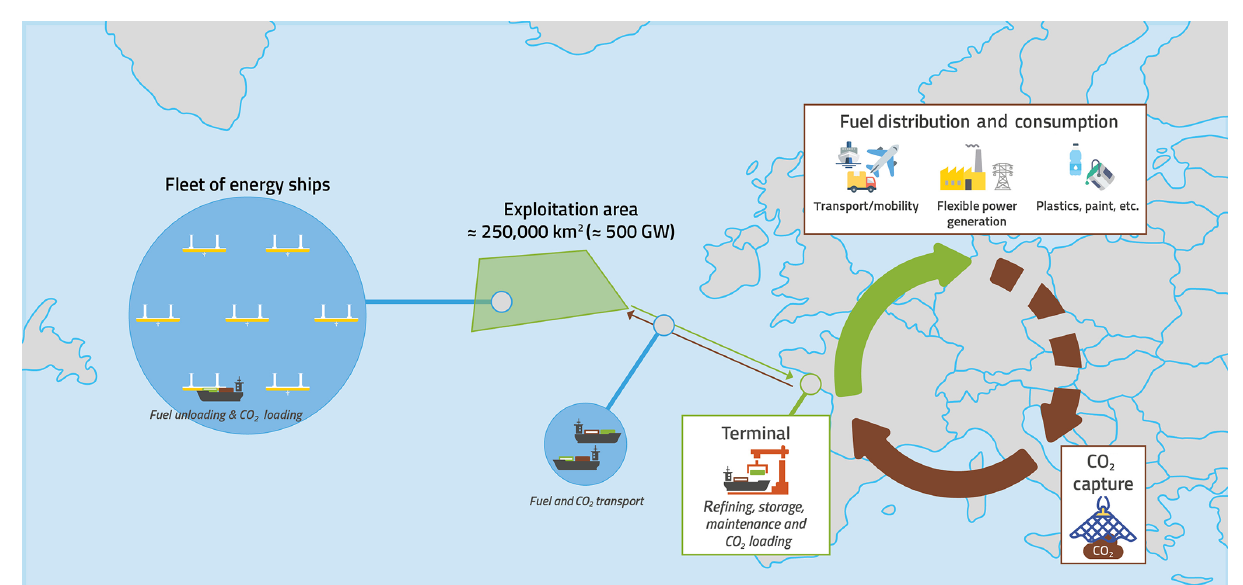
Figure 2. The concept of sustainable methanol production from far-offshore wind energy by FARWIND energy